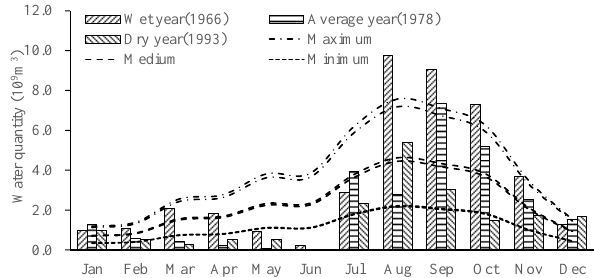
Fig. 5. Monthly environmental flow and natural river discharge in wet (1966), average (1978), and dry years (1993).